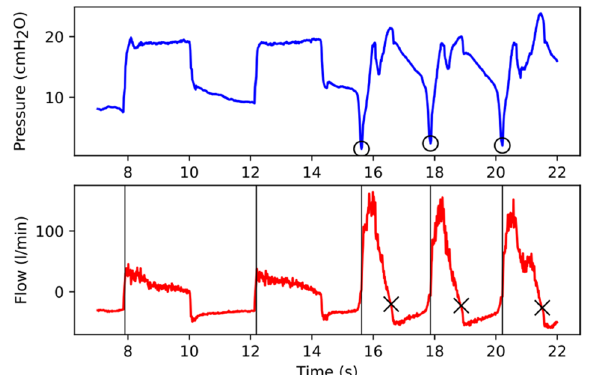
Figure 3. Illustration of patient-triggered and patient-cycled ventilation. The plots show the measured airway pressure (blue) and flow (red) as a function of time in the event of spontaneous breathing during ventilation (from ~ 16 s). The patient-initiated start of the inhalation and exhalation phase is marked as ‘o’ and ‘x’, respectively.